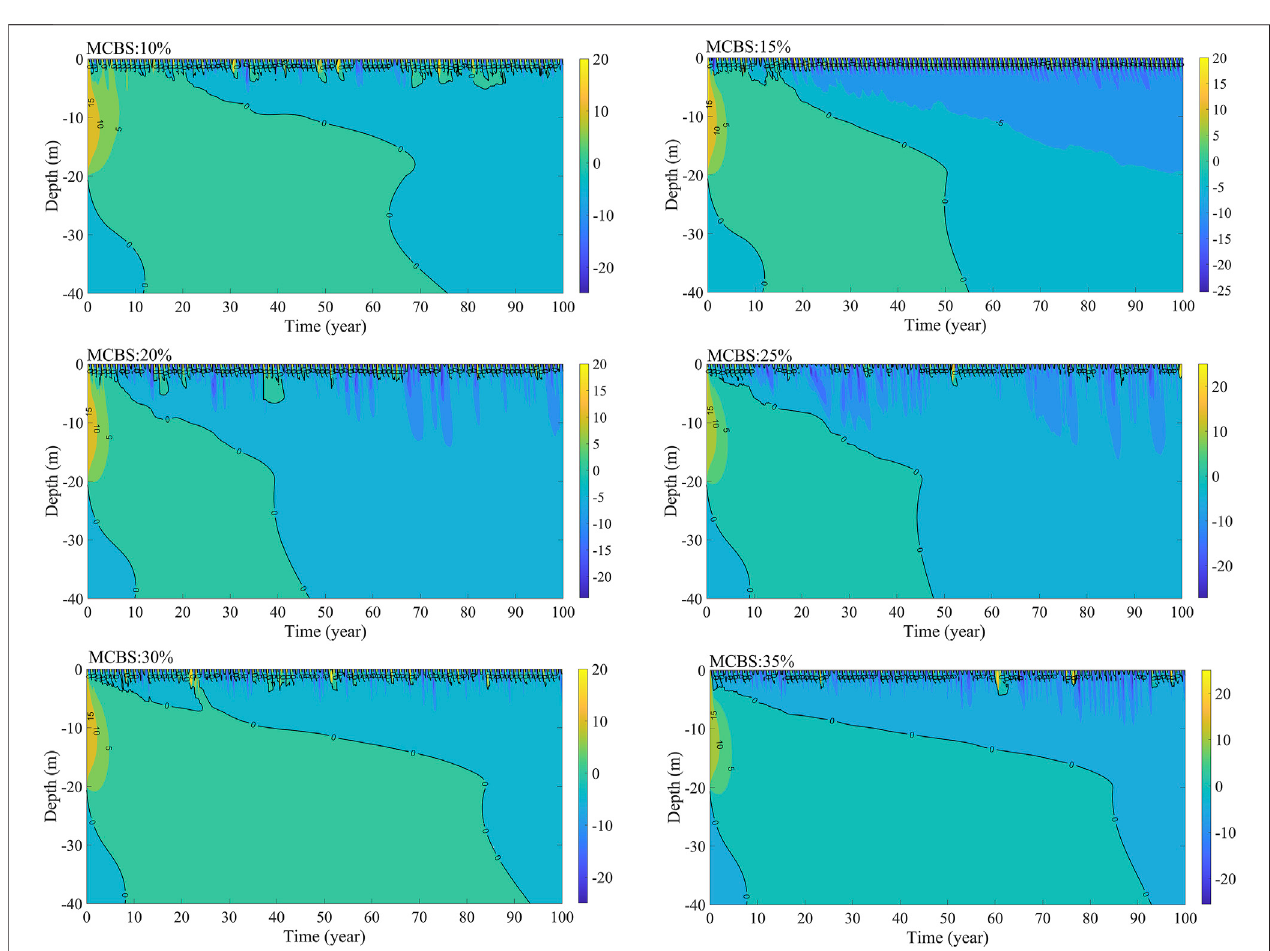
FIGURE 10 | Temporal variations in ground temperature of back fi ll centerline under different soil moisture content (MCBS) (10, 15, 20, 25, 30, and 35%).